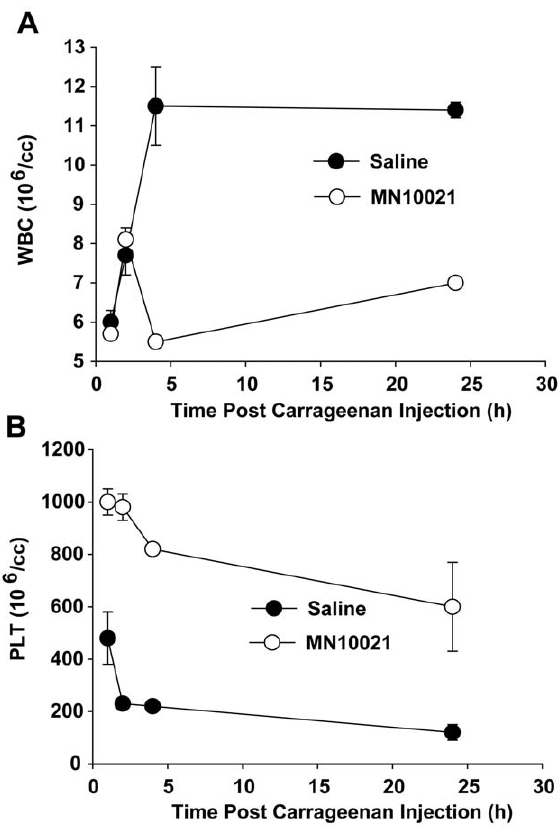
Figure 3. Effect of MN10021 on blood leukocyte and platelet counts in murine DIC model. Each of 4 groups of 5 CD-1 mice (male, 6–8 weeks of age) was injected i.p with 1.0 ml of either saline (closed circles) or 1.0 mg (245 nmol) MN10021 in saline (open circles). Eighteen hours later all mice were injected i.p. with 1.0 ml of 0.45% carrageenan. At each of the indicated times one group of 5 mice for each treatment was euthanized, an anti-coagulated blood sample obtained by cardiac puncture, and total white blood cell (WBC) (panel A) or platelet (PLT) (panel B) counts performed on an automated hematology analyzer. In both panels the dotted line represents the average value obtained from the blood samples of 10 untreated CD-1 mice. The data plotted are the mean values 6 SE. Error bars were calculated for all values and if not visible are contained within the symbol.